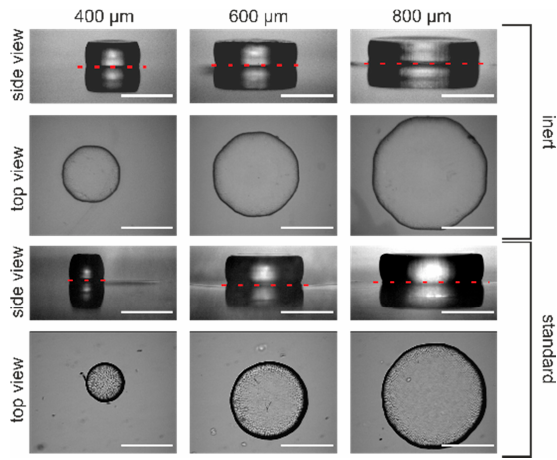
Figure 7. Results from polymerisation processes under different conditions. Hydrogels were covalently cross-linked to the glass surface during the polymerisation process. Therefore, a reflection of the gels in the side views is observable with the plane of reflection indicated by the red dashed lines (white bar = 400 µ